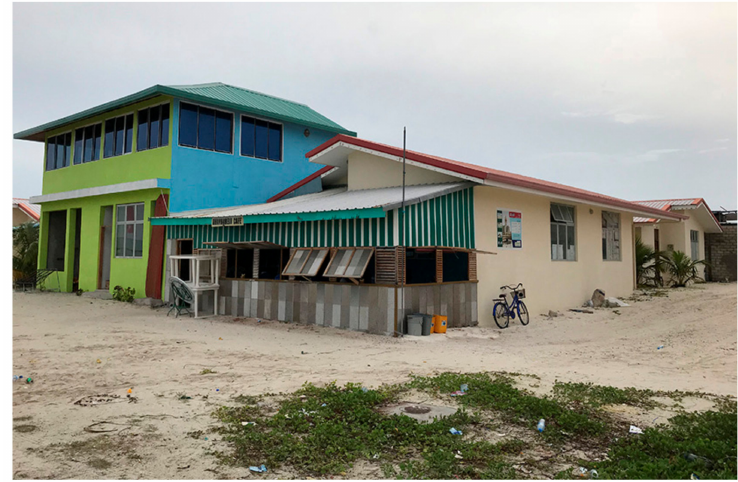
Figure 1. Houses in Dhuvaafaru with extensions and modifications; the house on the left was extended into a 2-storey structure (source: Iftekhar Ahmed, University of Newcastle,